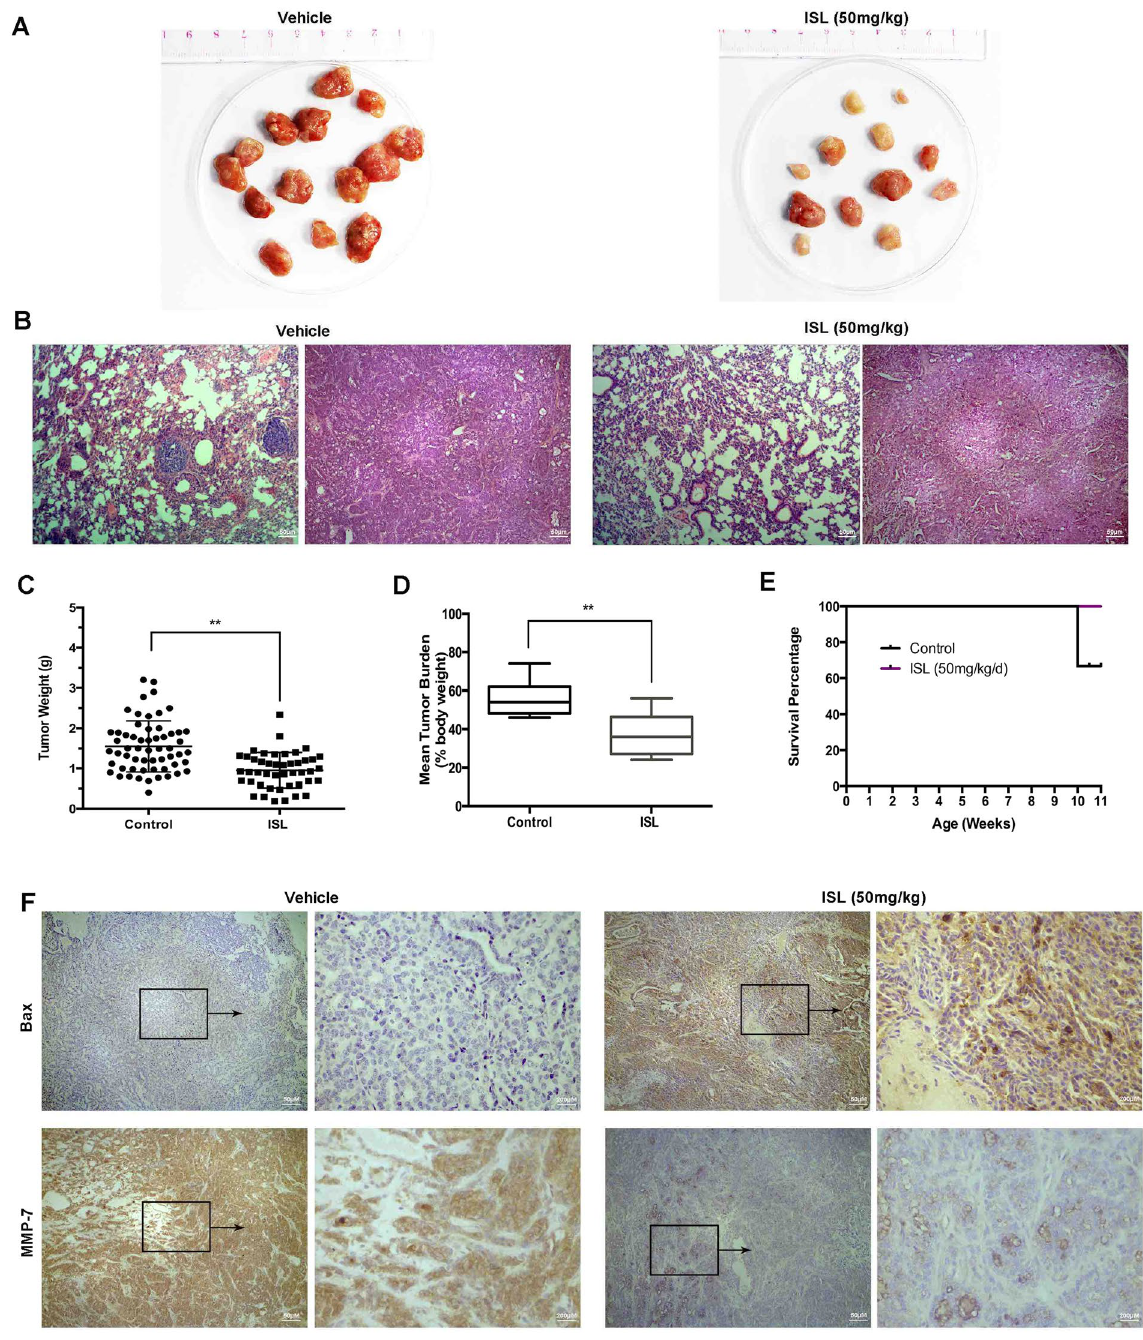
Figure 2. ISL inhibits tumorigenesis and metastasis in MMTV-PyMT transgenic mice. ( A ) Representative images of solid tumors collected from vehicle group and ISL treatment group (50 mg/kg/d). ( B ) Representative micromorphology of the dissected tumors and lungs with HE staining in 100-fold magnification. ( C ) Scatter plots of individual tumors with mean weights at the end point of ISL treatment (n = 6). ( D ) Data about tumor burden of mice from vehicle and ISL-treated (n = 6). ( E ) Kaplan-Meier curve of mice survival in two different groups after ISL administration (n = 6). ( F ) IHC staining analysis of Bax and MMP-7 in vehicle tumor tissues and ISL-treated tumor tissues. Data represent the mean ± s.d. ** P <